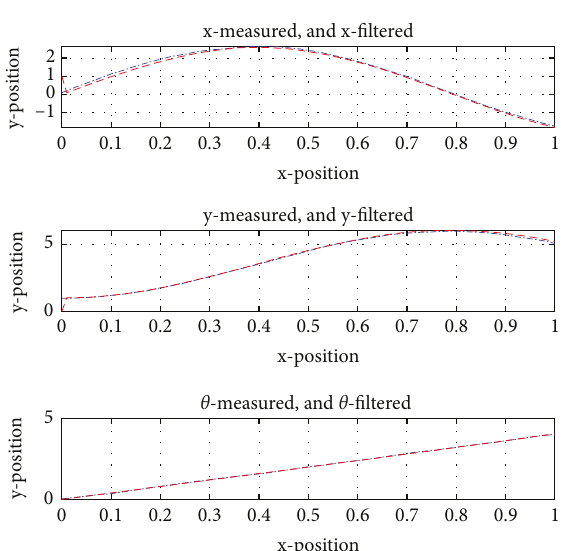
Figure 17: PF performance with two landmarks and Gaussian noise.